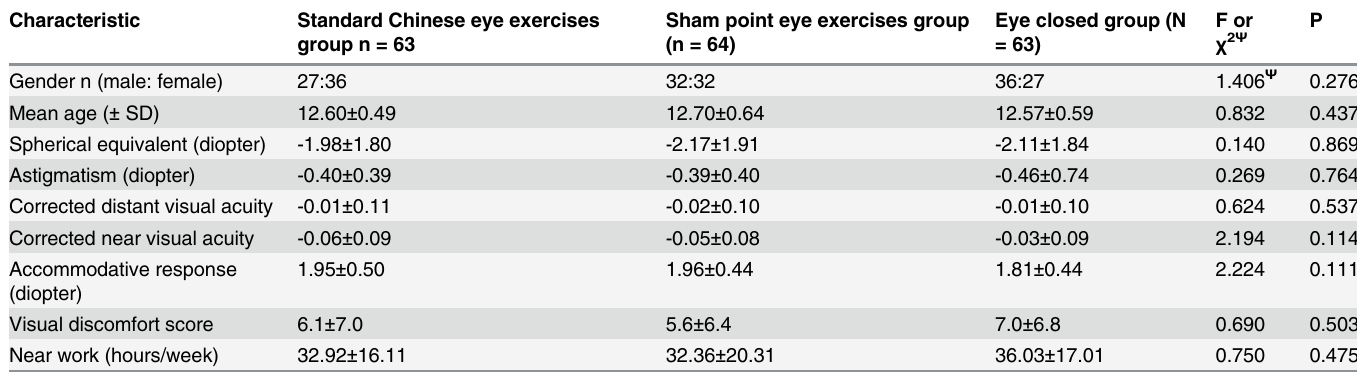
Table 2. Baseline Characteristics of Study Participants in Three Groups. *